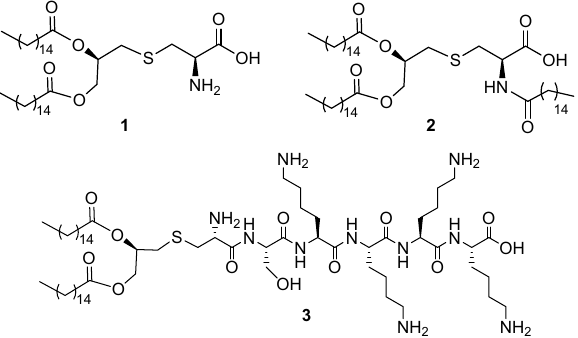
Figure 1. Structures of Pam 2 Cys ( 1 ), Pam 3 Cys ( 2 ) and Pam 2 CysSK 4 ( 3 ).